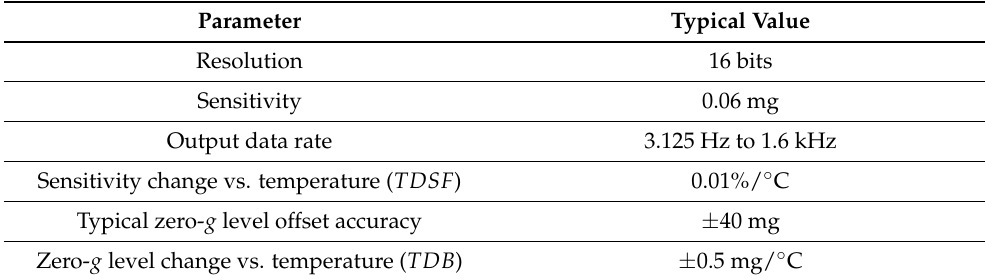
Table 3. Typical characteristics of the LIS3DSHTR MEMS accelerometer in the ± 2 g range